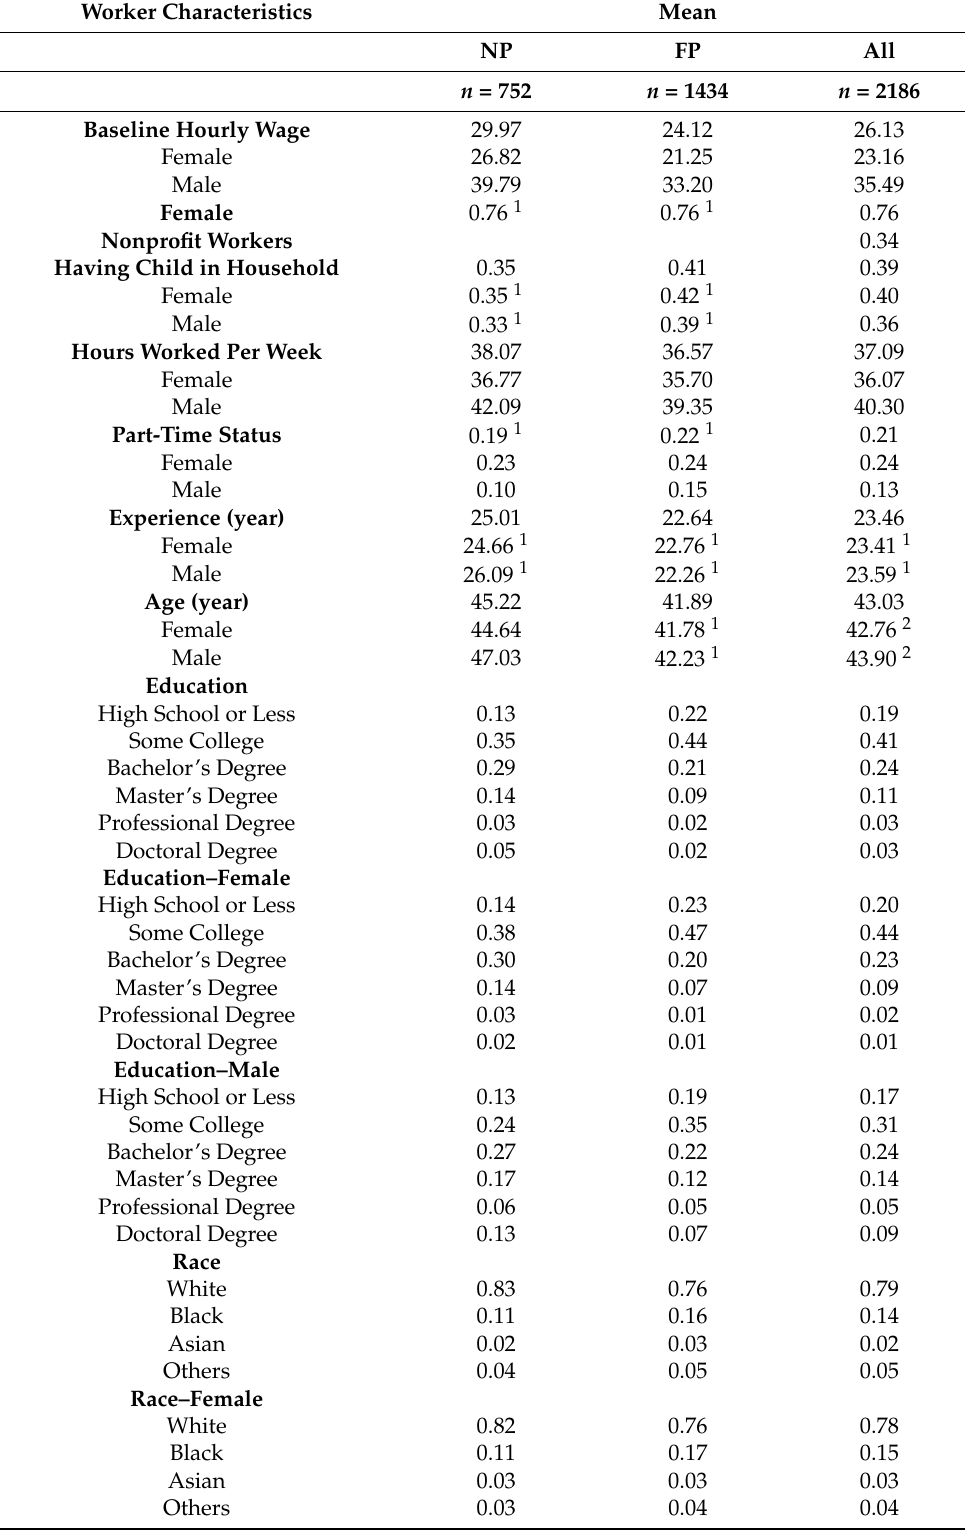
Table 1. Baseline worker characteristics of NP Stayers and FP Stayers (Part